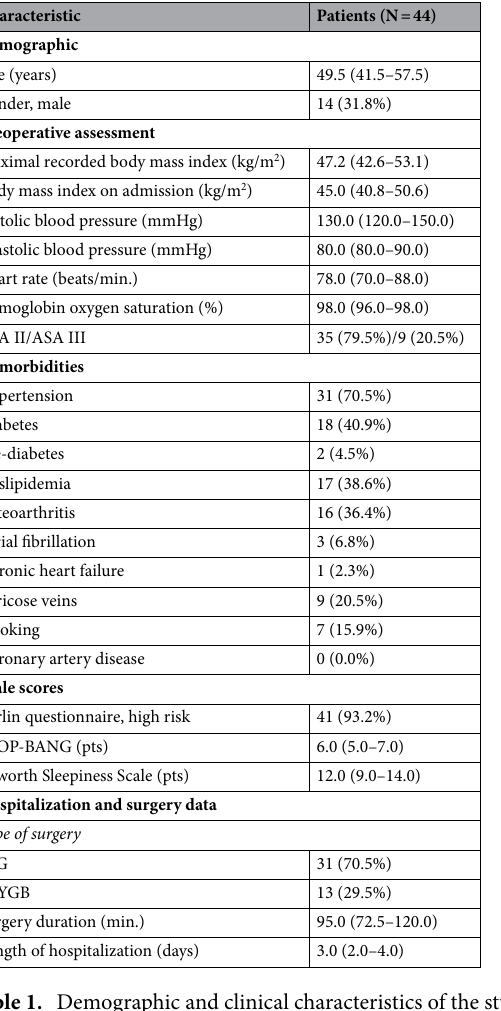
Table 1. Demographic and clinical characteristics of the study group. ASA, American Society of Anesthesiologists; LSG, laparoscopic sleeve gastrectomy; LRYGB, laparoscopic Roux-en-Y gastric